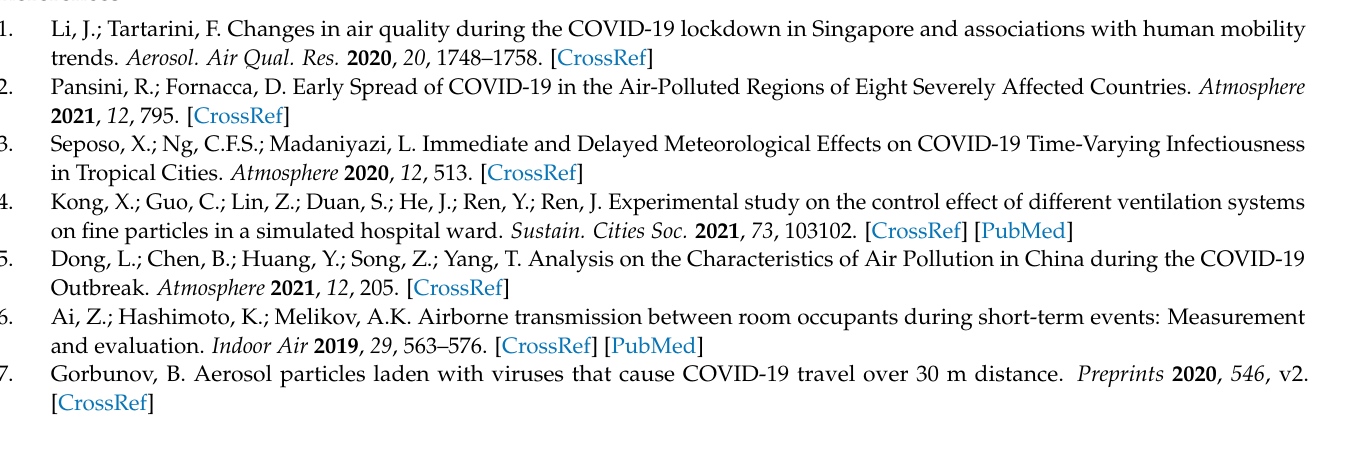
b are for 20% sucrose solution; c and d are for olive oil; Figure S3: The relationship between mass concentration of sucrose solution and aerosol concentration; Figure S4: The mass-based filtration efficiency of MERV 7, 10, 13, 16 rated filters measured; Table S1: Particle size distribution in the size range of 16 nm-20 µ